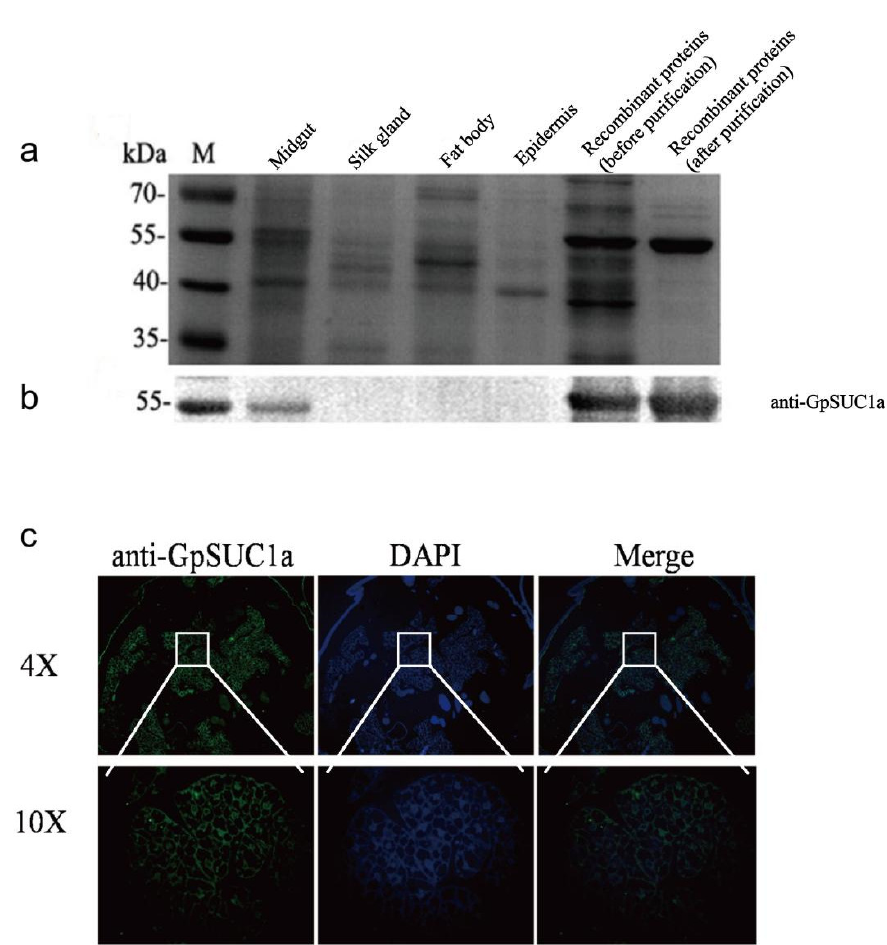
Figure 3. Expression pattern and localization of GpSuc1a protein. Expressional patterns of GpSUC1a in different tissues by SDS-PAGE ( a ) and western blot ( b ) analysis. ( c ) Immunohistochemistry analysis of GpSuc1a protein in the midgut. The midgut sections incubated with the secondary antibody labeled with IgG/Alexa Fluor 488 (green) and DAPI (blue) as overlapping signals.